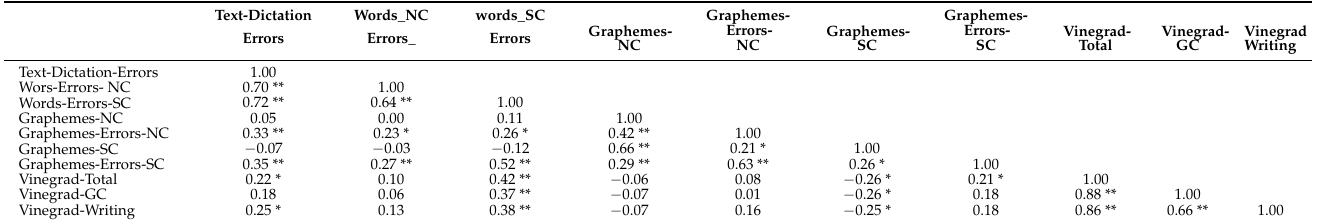
Table 1. Bivariate correlations between writing tasks and the Vinegrad+ questionnaire